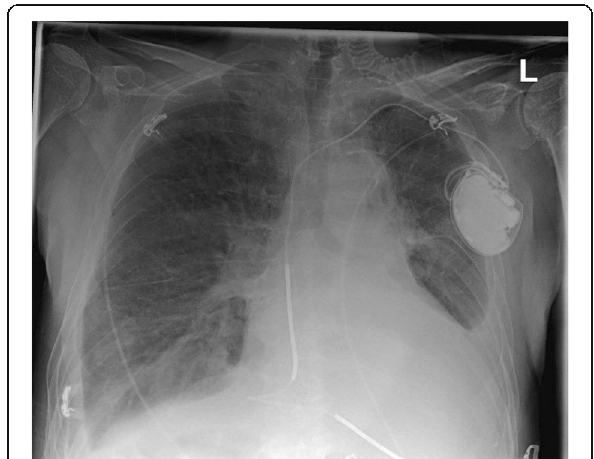
Fig. 1 X-Ray 03/25/2020, left-sided pulmonal fluids